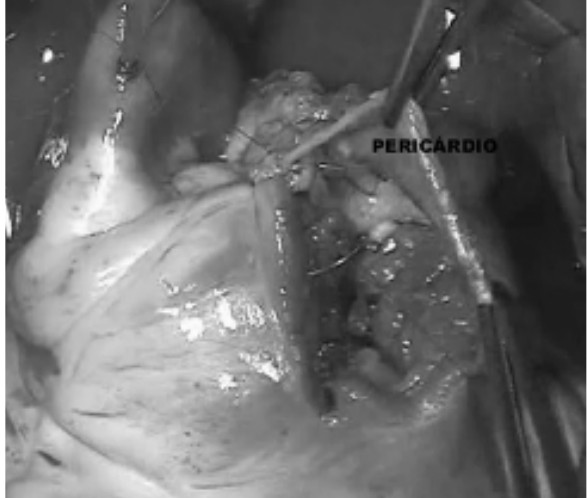
Fig. 2 – Pedicled pericardium used to complete the inferior part of the